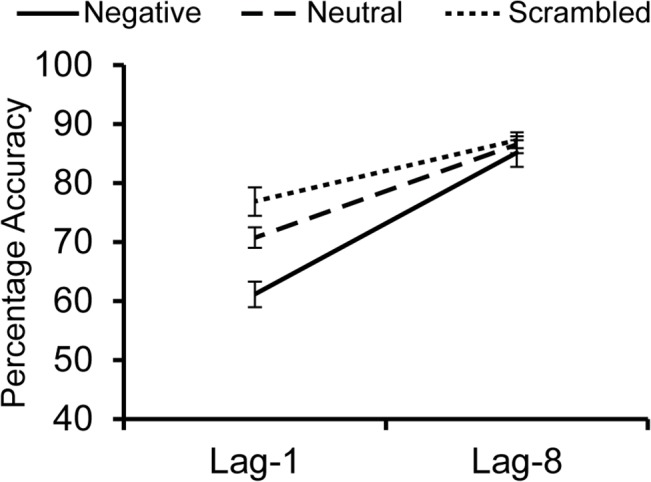
Average percent accuracies for target detection in Experiment 2.Emotion-induced blindness occurred when the target was presented one image (lag-1) after a negative distractor, but not when presented eight images (lag-8) after the distractor.